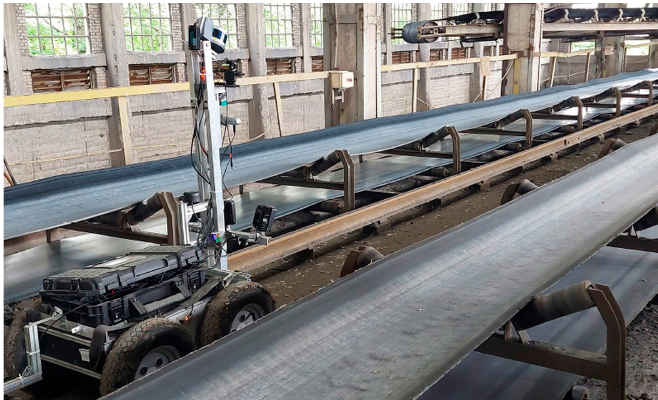
Figure 11. Conveyor Inspection Robot (Reprinted from Ref. [110]).